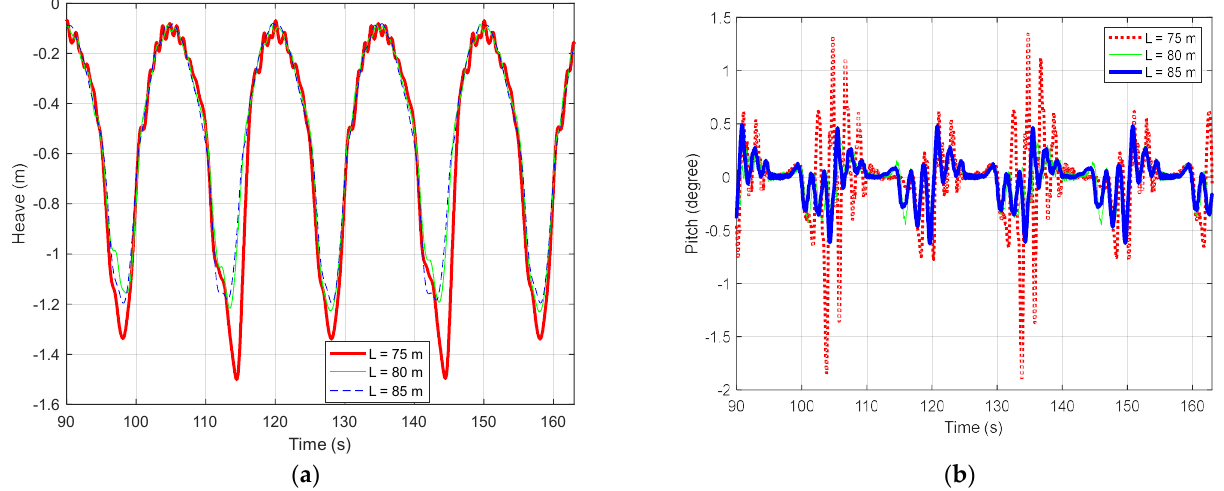
Figure 8. Out-of-plane motions with variations in mooring length. ( a ) heave time series ( b ) pitch time series. Table 5. Comparison of 6 DOF motions of foundations with different mooring lengths.